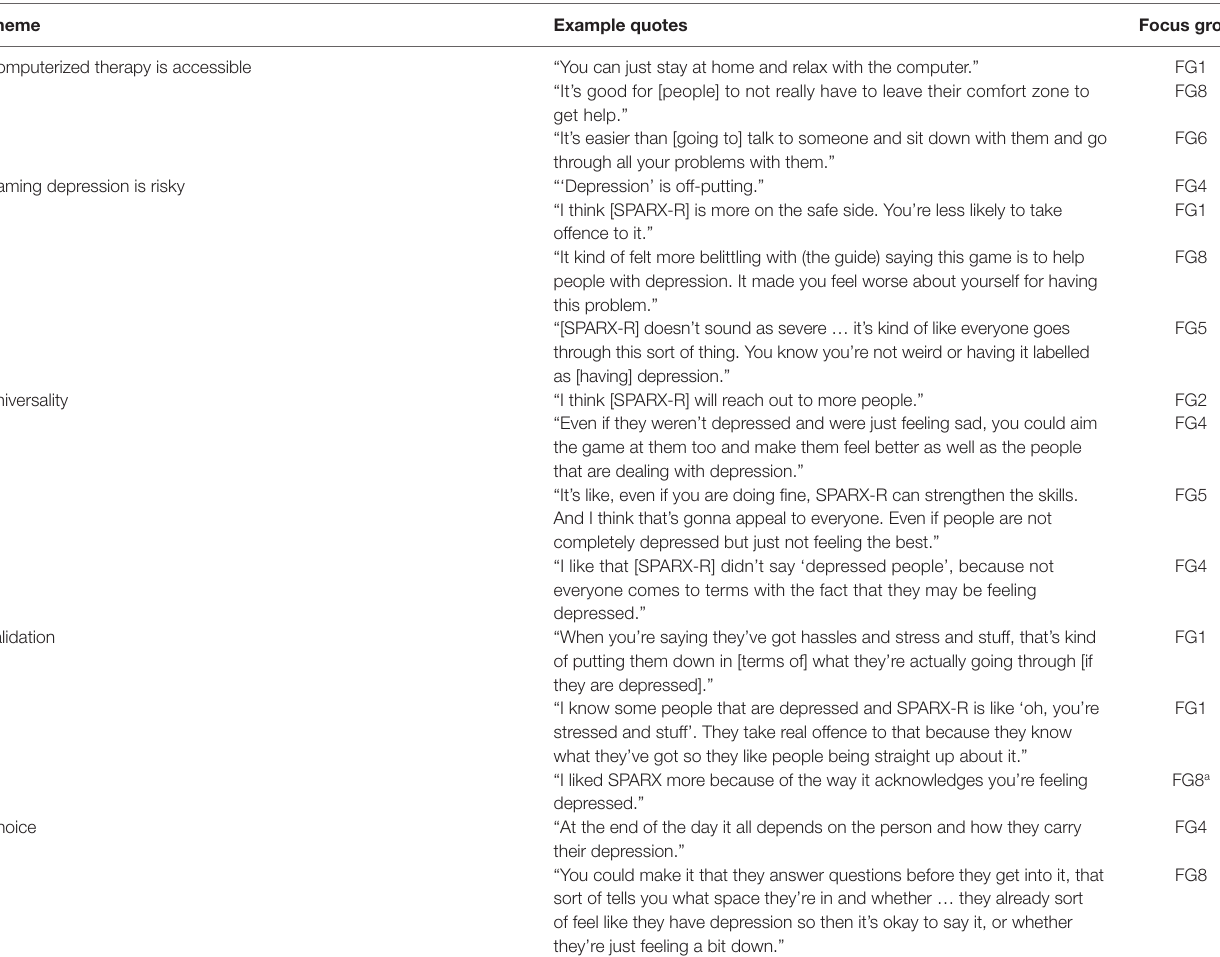
TABle 4 | Themes and example